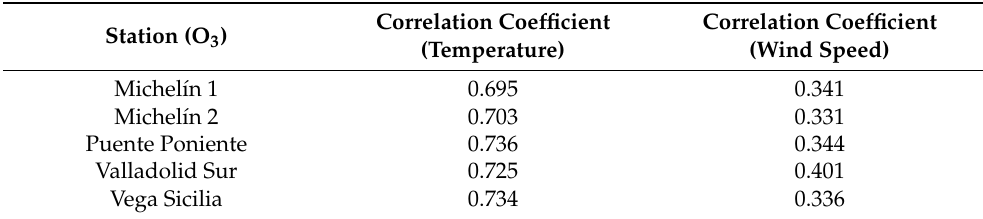
Table 6. Pearson correlation coefficients between ozone concentrations and meteorological variables for each measuring station at a 95% confidence level. Station (O 3